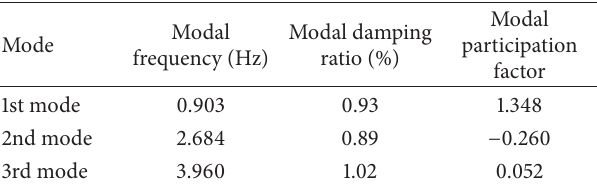
Table 14: Estimation results of dynamic characteristics for Case 3 .